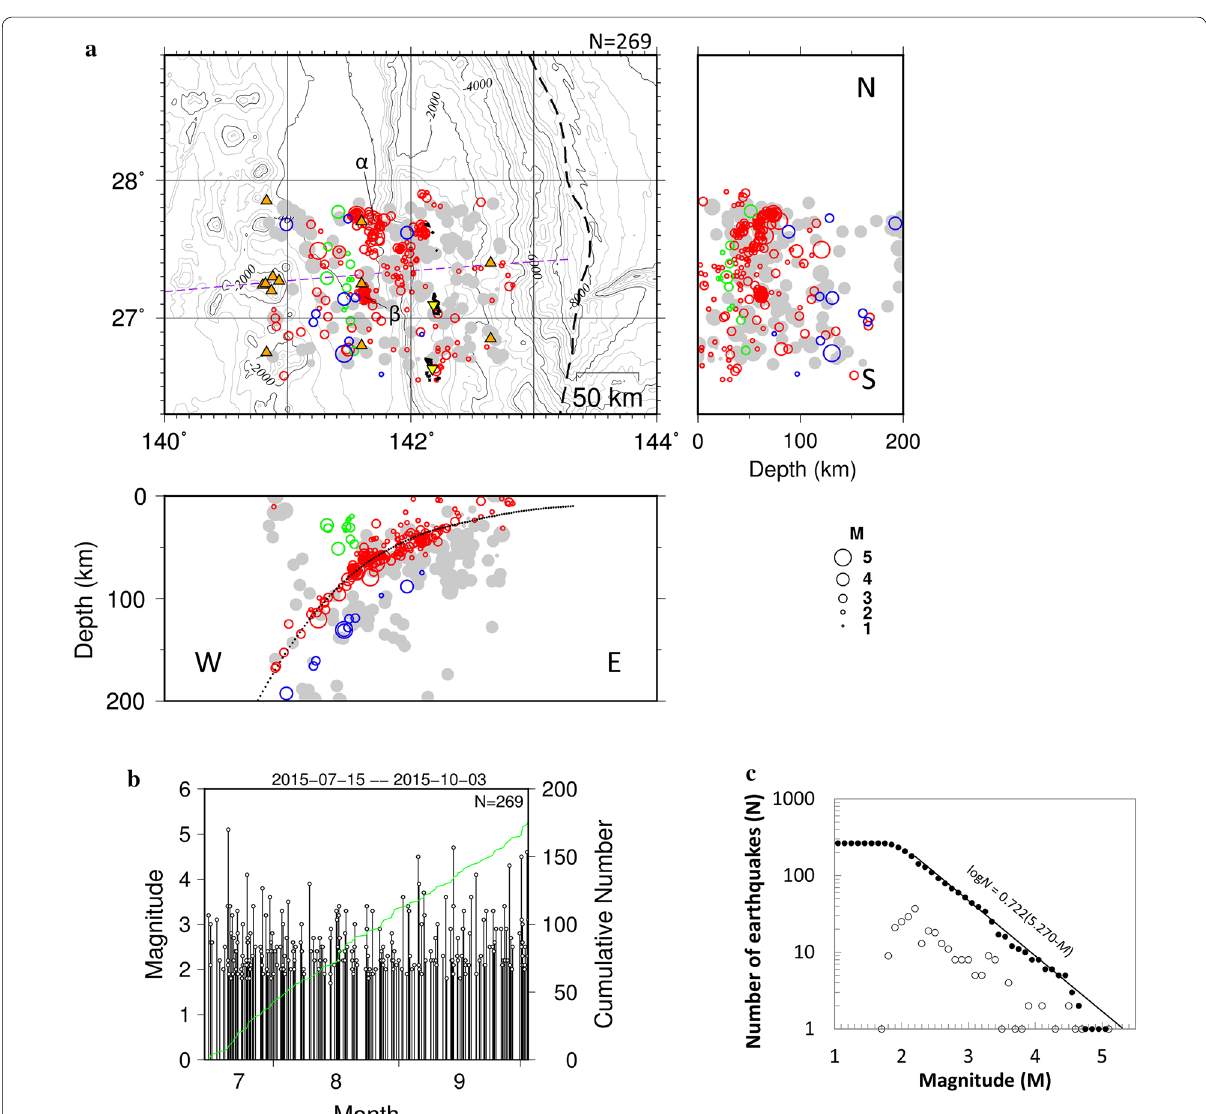
Fig. 4 Hypocenters determined in this study. a Map view and N–S and E–W vertical cross sections showing the hypocenter distribution (open circles) determined from the data recorded by OBSs (orange triangles) and the two island stations (inverted yellow triangles) from 15 July to 10 October 2015. The diameters of the circles indicating hypocenters vary according to the magnitude of the earthquake. Hypocenters in the upper seismic zone are shown by red circles, and those in the lower seismic zone by blue circles. Hypocenters away from the plate boundary are shown by green circles. SBJ hypocenters determined with high precision from January 2002 to December 2017 around the deployment area of the OBSs are also shown by solid gray circles. The dashed purple line in the map view shows the survey line of Takahashi et al. (2009). The dotted black line in the E–W cross section indicates the upper surface of the Pacific slab along 27.3°N, as determined by Hayes et al. (2012). α and β indicate two clusters of hypocenters at 60–80 km depth. b Magnitude-time diagram. The green line shows the cumulative number of earthquakes with M 2.2 or greater. c Magnitude–frequency distribution. Open circles denote the number of earthquakes in each magnitude bin, and solid circles show the cumulative number of earthquakes. The best-fit line according to the Gutenberg–Richter law is also shown (Gutenberg and Richter